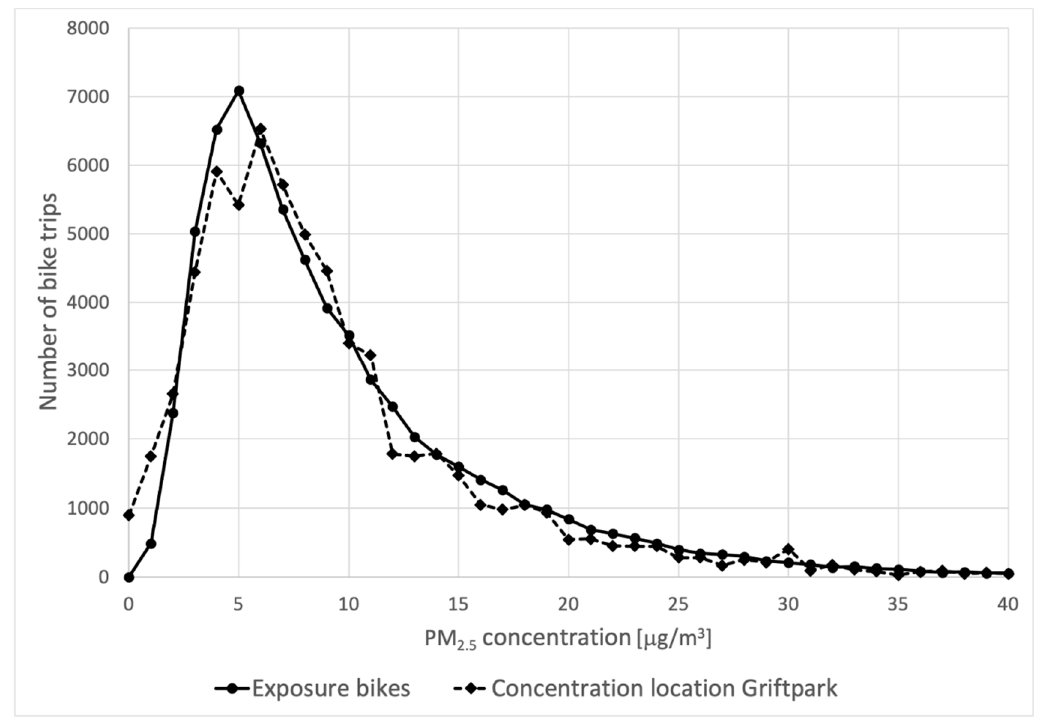
Figure 10. Number of times total PM 2 . 5 concentrations were measured by the bicycles and the urban background concentrations in the city of Utrecht (dotted line).